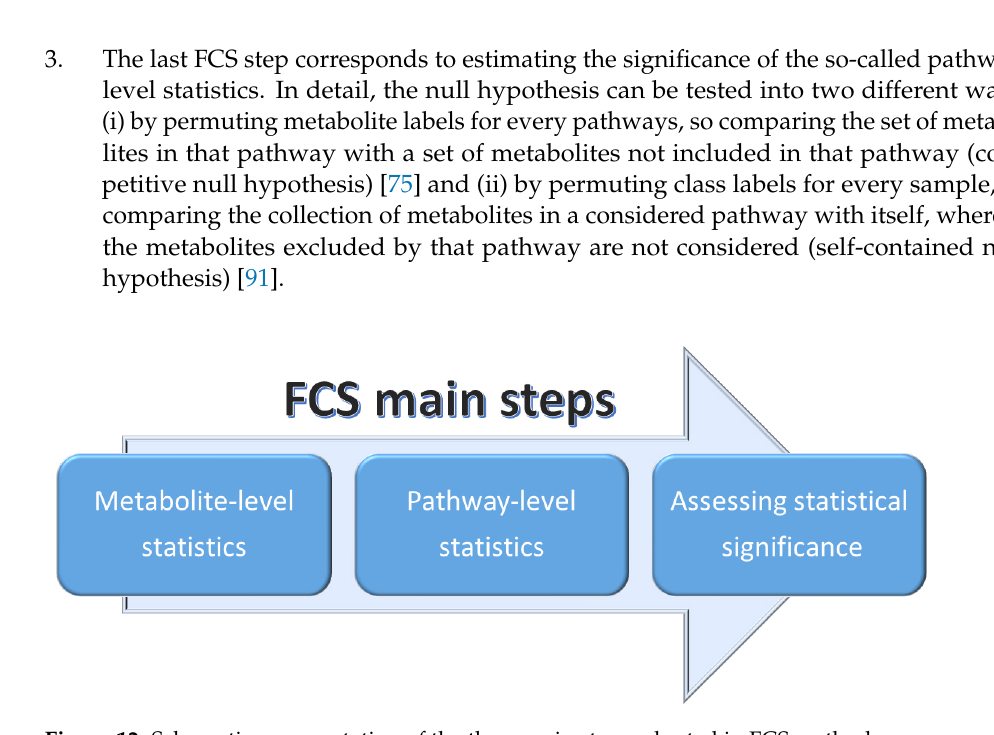
Figure 12. Schematic representation of the three main steps adopted in FCS